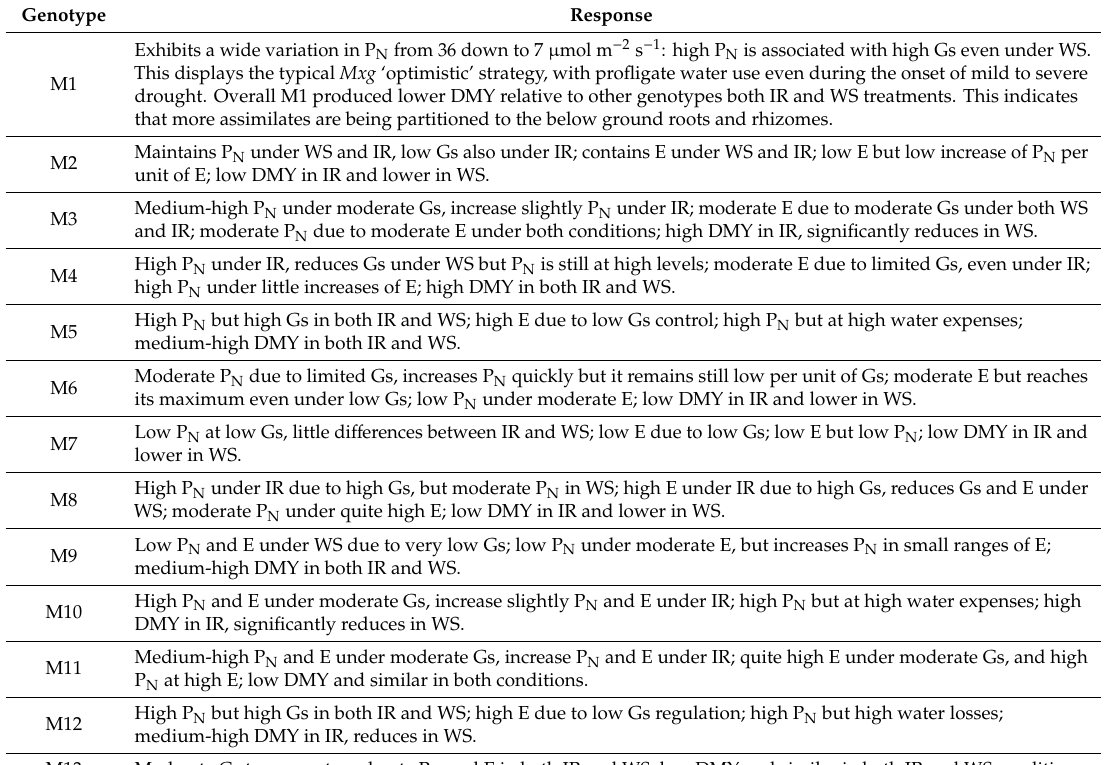
Table 5. Genotypic response (M1— Mxg , M2— M . sacchariflorus , M3–M6— M . floridulus , M7–M13— M . sinensis ) under rainfed (WS) and favorable (IR)